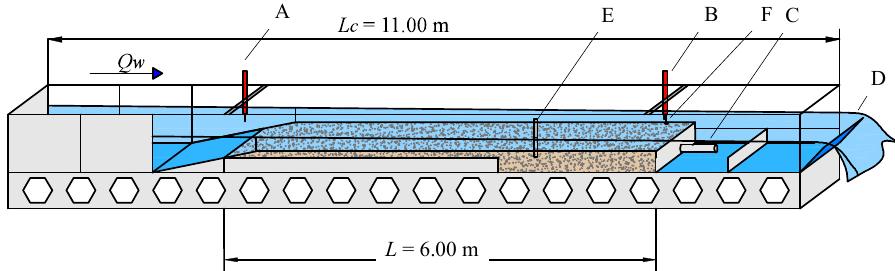
Figure 2. Test flume construction (dimensions in meters), where: Q w – water discharge; A—pin water gauge; B—sound probe equipped with movable pin gauge (F); C—collection chamber with the drainage; D—regulatory gate; E—pier; L c —total flume length; L —sandy bed length.